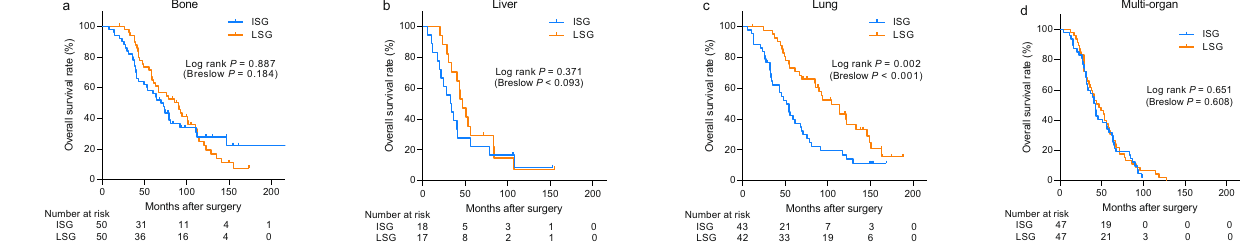
Figure 3. Kaplan–Meier curves showing overall survival depending on initial metastases sites. The survival curves for patients with bone (a) , liver (b) and multiple metastases (d) showed no significant differences between the two groups. However, the intensive surveillance group showed a significantly low overall survival among patients with lung metastasis (c) . ISG intensive surveillance group, LSG less-intensive surveillance group.